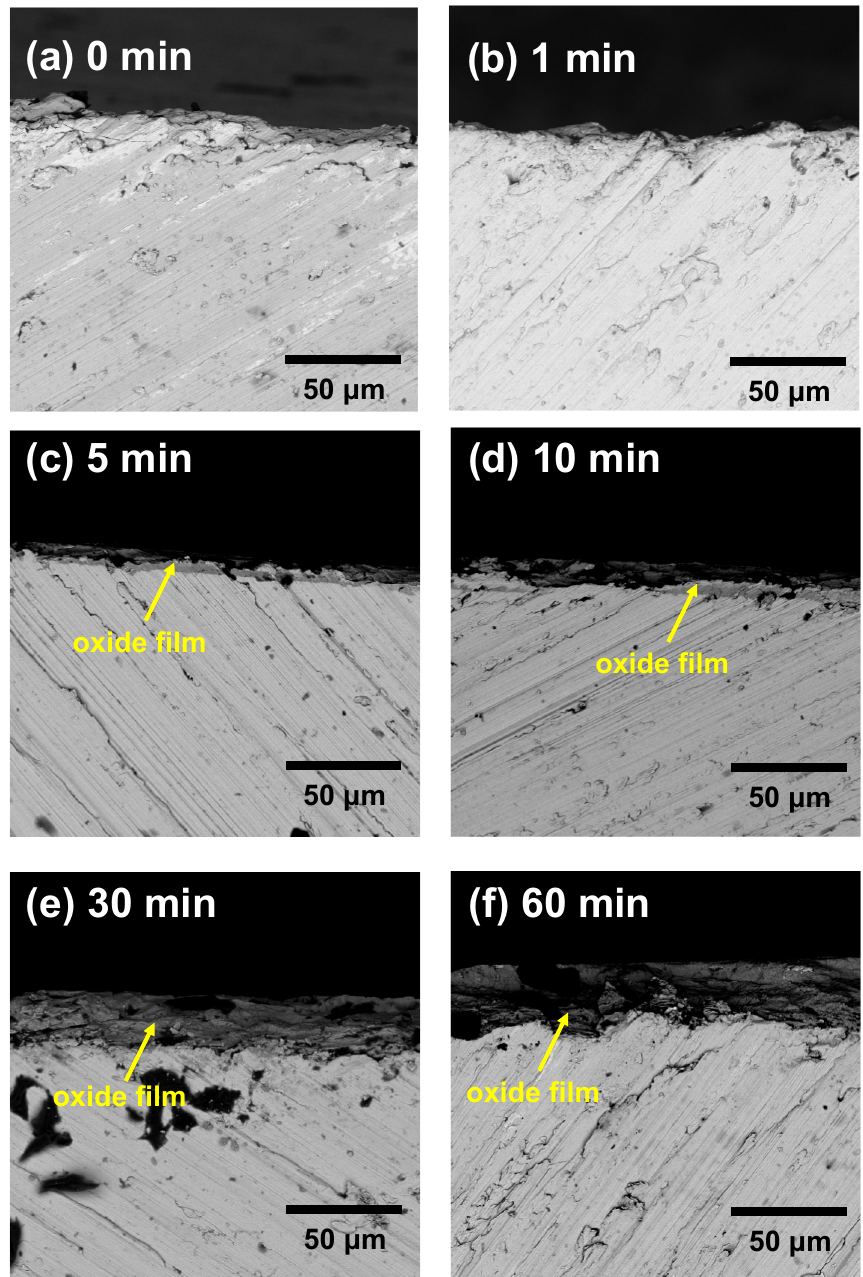
Figure 3. Cross-sectional view SEM images of the TiZr alloy specimens heat-treated at 600 °C for ( a ) 0 min, ( b ) 1 min, ( c ) 5 min, ( d ) 10 min, ( e ) 30 min, and ( f ) 60